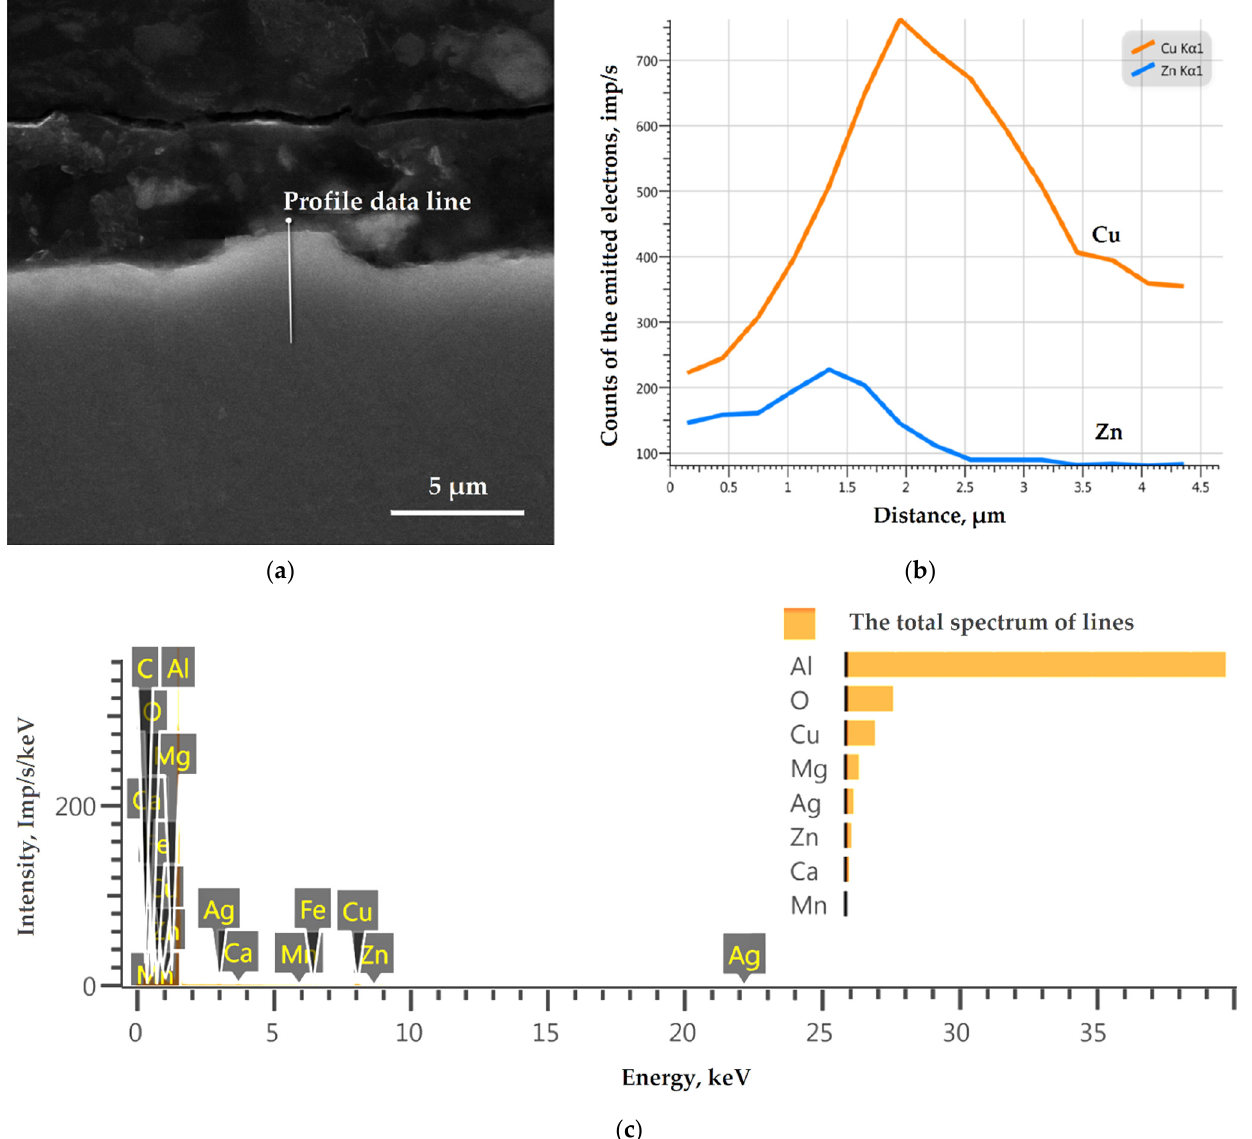
Figure 11. Nanomodification of 2024 (D16) duralumin sample subsurface layers at cross-sectional area: ( a ) SEM in secondary electrons; ( b ) energy dispersive spectroscopy (elemental analysis) along the profile line; ( c ) energy dispersive spectroscopy of the profile line.